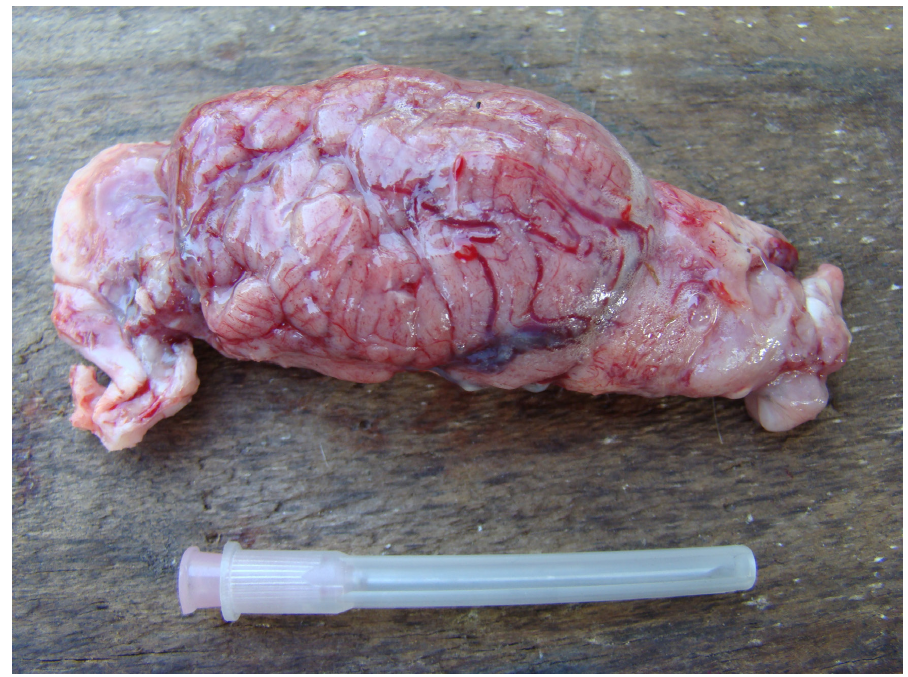
Figura 1. Região prosencefálica (telencéfalo e diencéfalo) de tamanho reduzido e rudimentar, sem divisão dos hemisférios cerebrais e circunvoluções cerebrais pouco